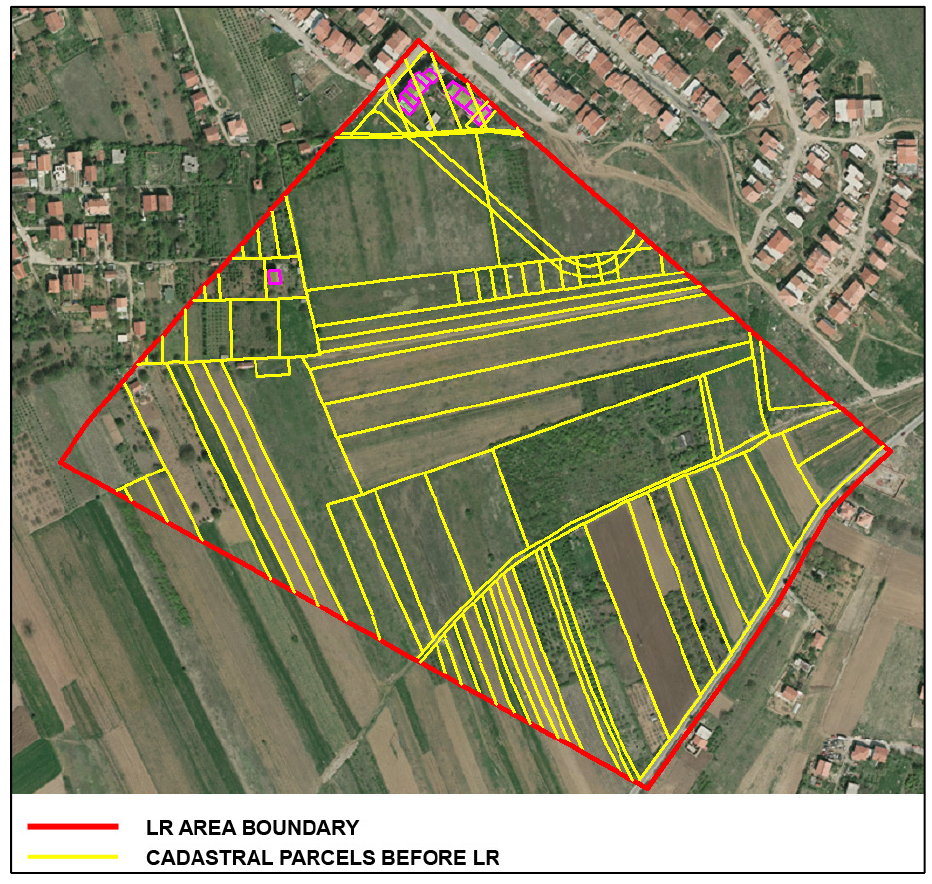
Figure 5. Cadastral parcels before LR.